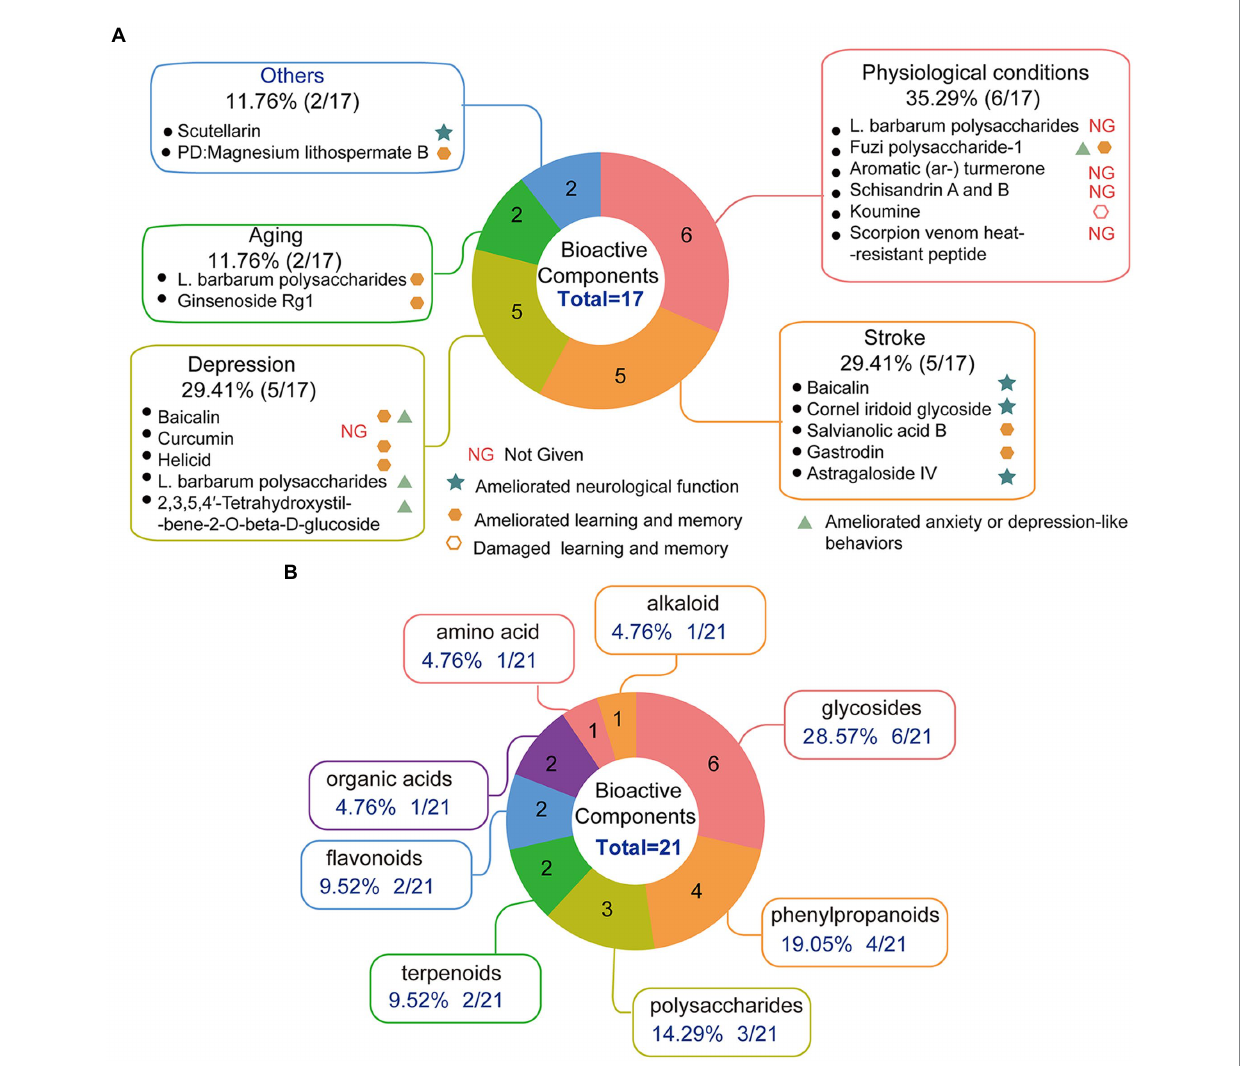
FIGURE 4 The effect of bioactive components on adult neurogenesis. (A) Pie chart of bioactive components improving adult neurogenesis and brain function, n = 17, L. barbarum polysaccharides improves adult neurogenesis in aging, depression, and physiological conditions, so it was counted in three cases for three situations; baicalin improves adult neurogenesis in depression and stroke conditions, so it was counted in two cases for two situations. (B) Pie chart of bioactive components according to the chemical composition that promotes adult neurogenesis (animal) or contributes to the proliferation and differentiation of NSCs, n =